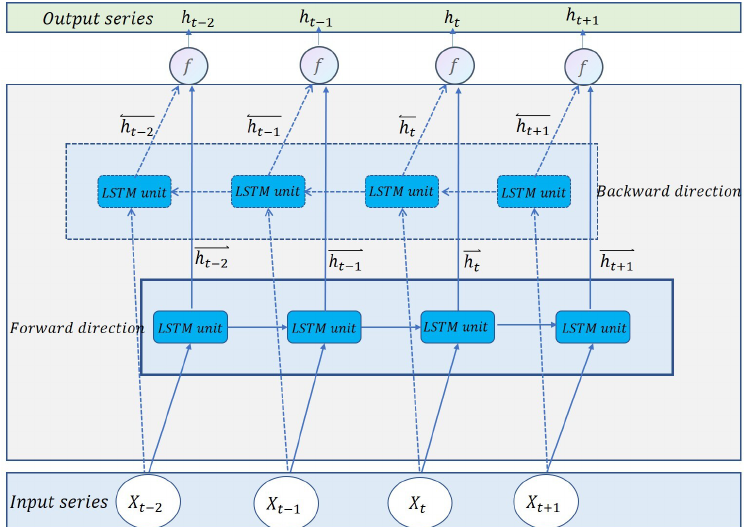
Figure 2. The structure of